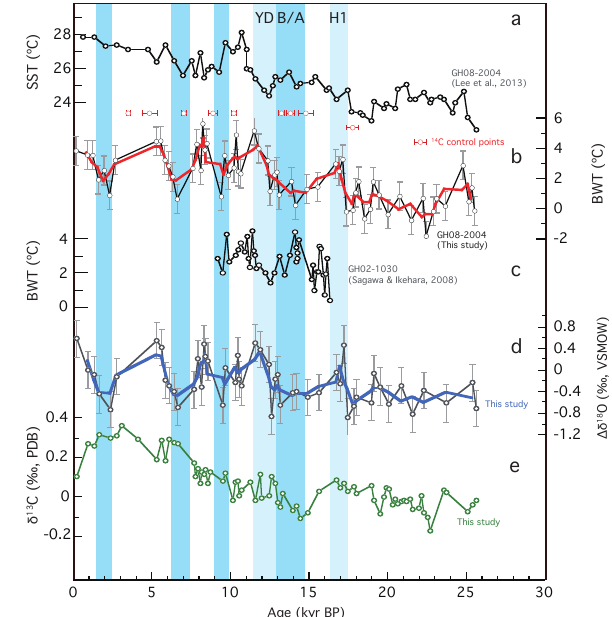
Figure 8. (a) Mg / Ca, (b) perfect test % (in black) and MFI (in blue), (c) δ 18 O c (original values), and (d) δ 13 C c (original values) vs. calendar age for GH08-2004. (c, d) Filled red circles represent δ 18 O c and δ 13 C c data from C. wuellerstorfi type A, and open cir- cles represent C. wuellerstorfi type B. H1, B/A, and YD represent Heinrich 1, Bølling–Allerød, and Younger Dryas intervals. The bold line in (a) indicates three-point running mean. Analytical errors are expressed as bars.